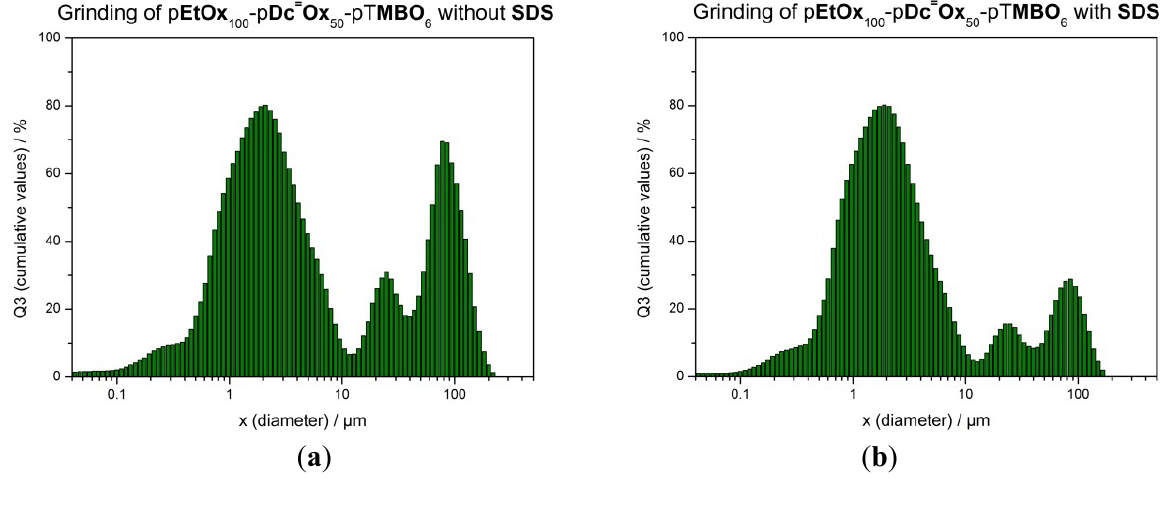
Figure 2. Particle size distributions of p EtOx ground in a ball mill as aqueous suspensions for 24 h: feeds of 100 mg gel in 15 mL of water ( a : 10%/50% particle size diameter after grinding = 0.80/3.06 µm) and feeds of 100 mg·gel, 100 mg of sodium dodecyl sulfate (SDS) and 15 mL of water ( b : 10%/50% particle size diameter after grinding = 0.72/2.33